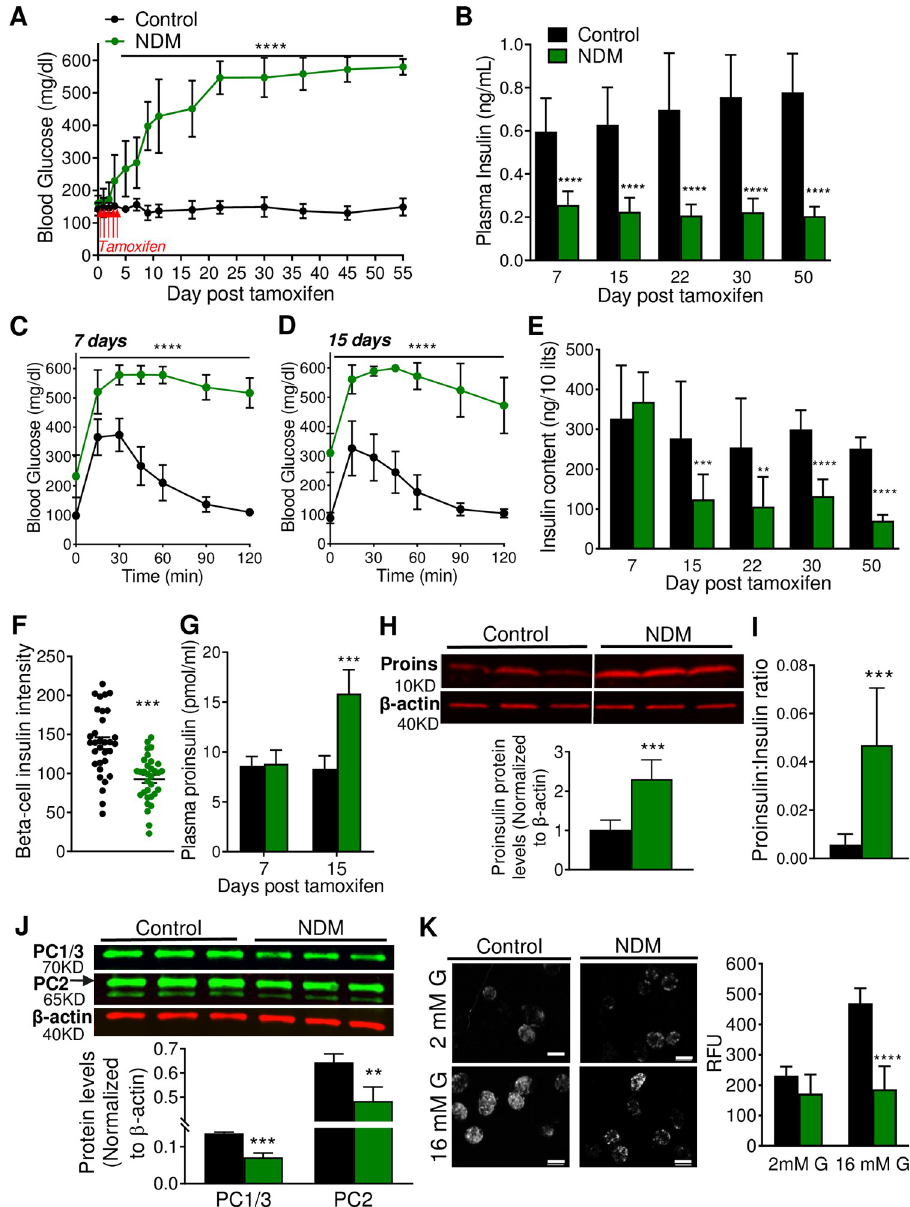
Fig 1. Loss of insulin content precedes loss of β -cell mass and identity in NDM (A) Non-fasting blood glucose and (B) Plasma insulin over time (n = 15–20 mice/group). Glucose tolerance test at day 7 (C) and 15 (D) post tamoxifen induction (n = 11–13 mice/group). (E) Total islet insulin content per 10 islets at different days post tamoxifen induction (n = 8–10 mice/group). (F) β -cell intensity determined in pancreatic sections immunostained with insulin (n = 8 mice/group, 3 slides from each mouse). (G) Plasma proinsulin at day 15 post tamoxifen induction (n = 7–8 mice/group). (H) Western blot analysis of proinsulin protein, representative (top) and quantification (bottom) on islets at day 15 post tamoxifen induction (n = 6 mice/group). (I) Proinsulin:insulin ratio at day 15 post tamoxifen induction (n = 10 mice/group) measured by Elisa. (J) Western blot analysis of prohormone convertases 1/3 and 2, representative (top) and quantification (bottom) on islets at day 15 post tamoxifen induction (n = 4 mice/group). (K) Calcium imaging, representative (left) and quantification (right) at 2- and 16-mM glucose at day 15 post tamoxifen induction (n = 6 mice/group, scale-bar = 100 μ m). Black = controls and green = NDM. Data are expressed as mean ± SD. Significant differences �� P < 0.01, ��� P < 0.001, ���� P < 0.0001.